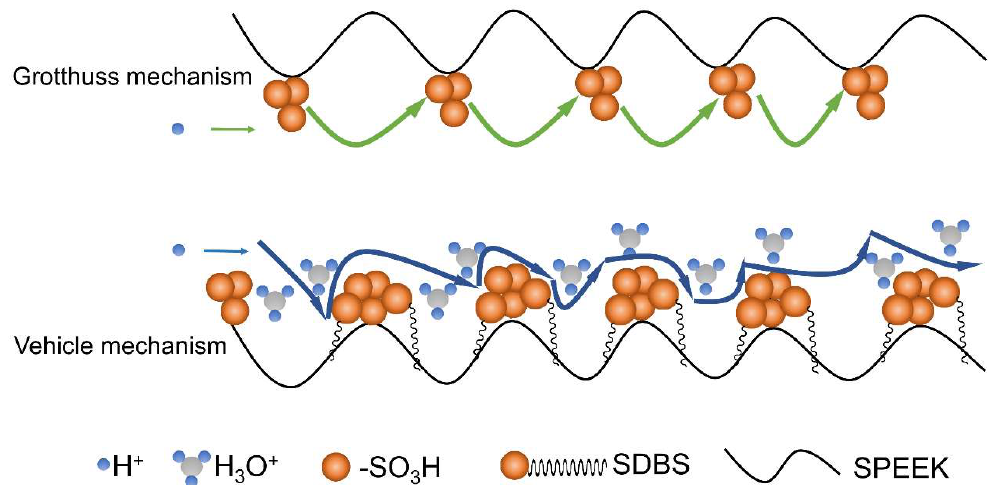
Figure 6. Schematic diagram of proton transport mechanisms in the SPEEK/SDBS membranes.